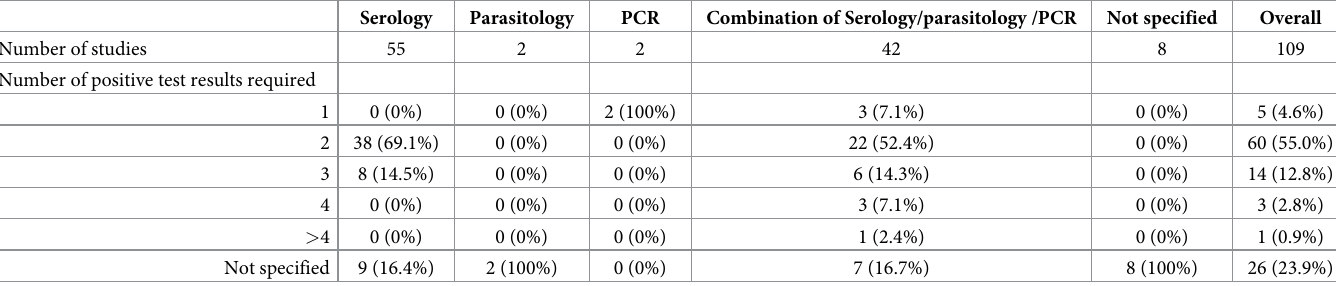
Table 1. Diagnostic criteria used for patient enrolment.